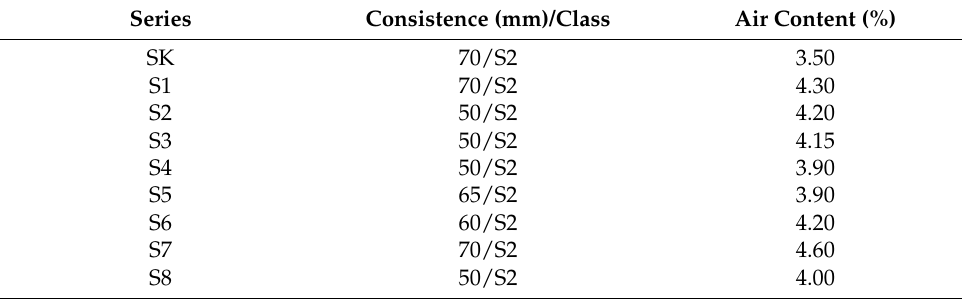
Table 3. Consistency class and air content of the tested concrete